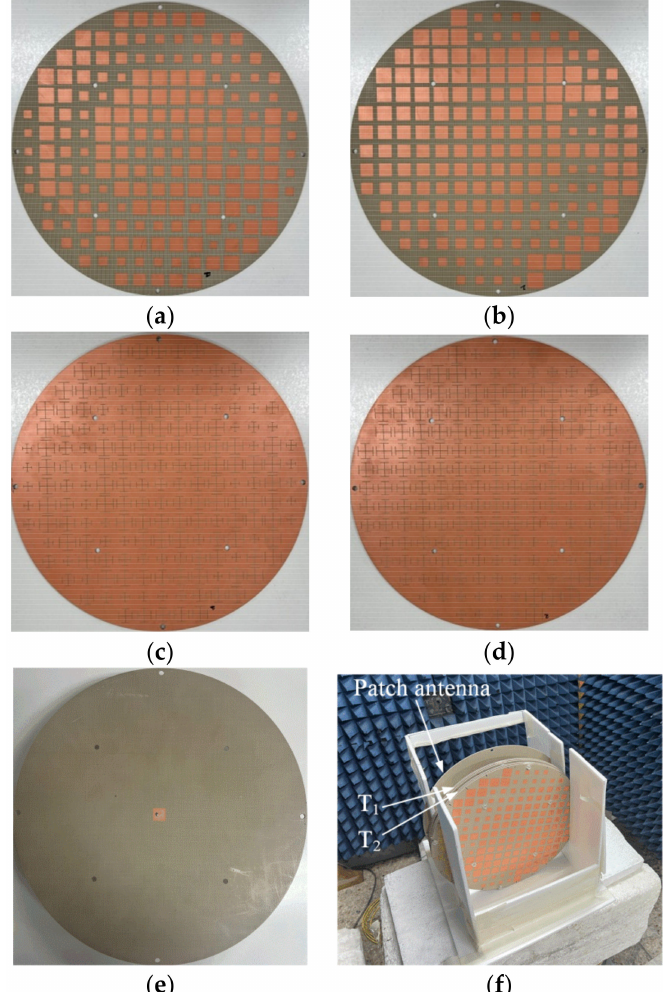
Figure 6. Photographs of the fabricated Moir é -inspired MSL system: ( a ) upper and lower layers of T (cid:48) ; ( b ) upper and lower layers of T 2 ; ( c ) middle layer of T (cid:48) 1 layer; and ( f ) fully assembled MSL